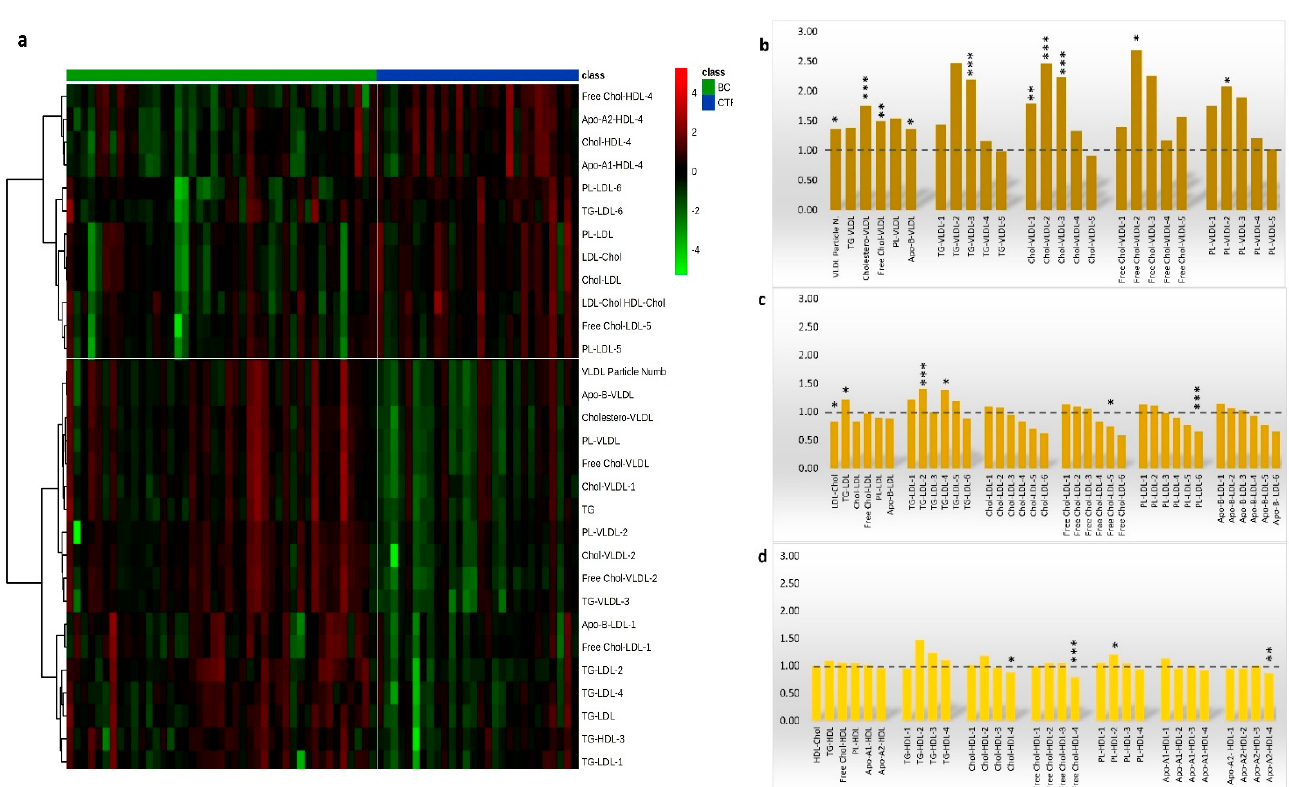
Figure 3. Heat maps of 1 H-NRM lipoproteins subfractions significantly differed between HER2-positive BC patients and the CTR group. High values are coloured in red while low values in green with a different brightness according to the magnitude of the difference when compared with the average value ( a ). Mean fold change in BC referred to CTR of the VLDL ( b ), LDL ( c ), HDL ( d ) main fractions, and subfractions. *** q < 0.001; ** q < 0.01; * q < 0.05.